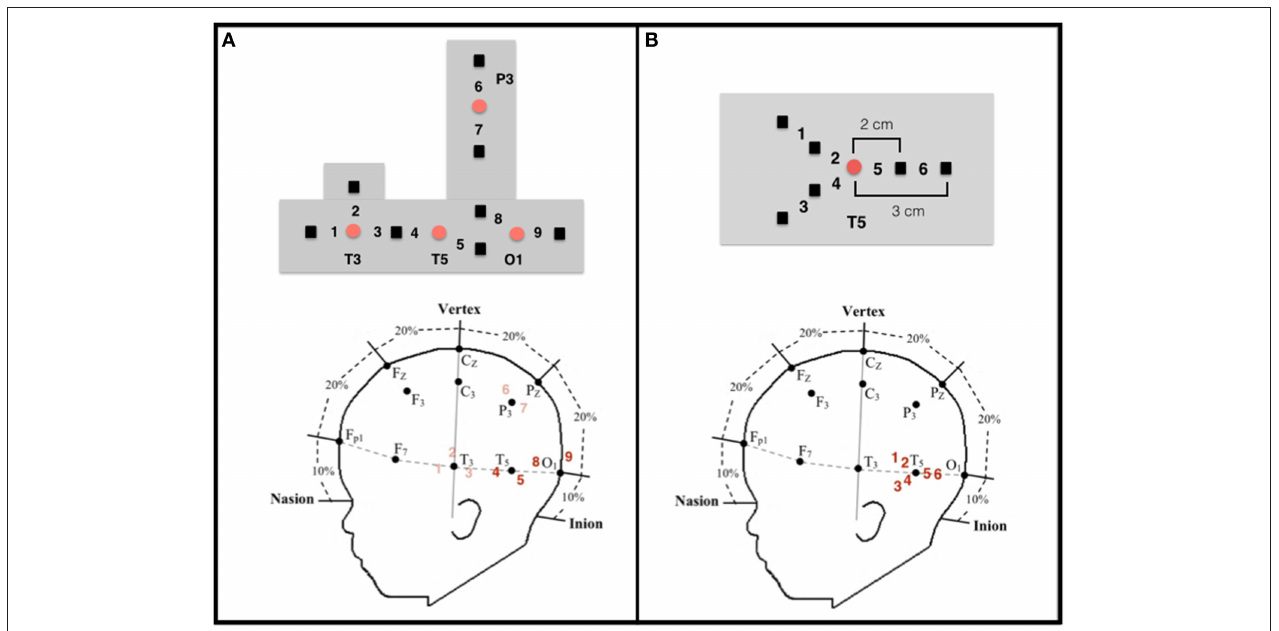
FIGURE 2 | Configuration and placement of optodes. (A) Top: Configuration of the emitters (red circles) and detectors (black squares) and the nine corresponding channels in the headgear used by Wilcox et al. (2010, 2012, 2014a). Emitter-detector distances were all 2cm. Bottom: Approximate location of the nine channels from which data were collected on a schematic of an infant’s head in relation to the 10–20 International EEG system. Each detector read from a single emitter except for the detector between T3 and T5, which read from both emitters. The light was frequency modulated to prevent “cross-talk.” Experiment 1 focused on data collected at channels 4 and 5 (posterior temporal cortex) and channels 8 and 9 (occipital cortex), which are in bold. (B) Top: Configuration of the emitter (red circle) and detectors (black squares) and the six corresponding channels in the headgear used in Experiment 2. Emitter-detector distances were either 2cm (channels 2, 4, and 5) or 3cm (channels 1, 3, and 6). For statistical analyses (see text), the channels were grouped into three regions within the posterior temporal cortex: Region I (channels 1 and 2), Region II (channels 3 and 4), and Region III (channels 5 and